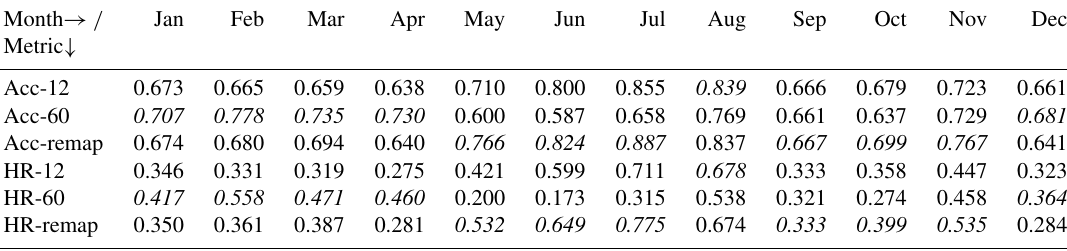
Table 3. Spatial coherence in the identification of extreme AOD values (i.e., areas with AOD>75th percentile over space for each month) between WRF-Chem at different resolutions relative to MODIS. No significant wavelength dependence is found for model skill in identifying extreme AOD so results are only shown for λ = 550nm. The different model output is denoted by 60 for simulations at 60km, 12 for simulations at 12km resolution and as remap for simulations at 12km but with the output remapped to 60km. The accuracy (Acc) indicates the fraction of grid cells co-identified as extremes and non-extremes between WRF-Chem and MODIS relative to the total number of cells with valid data. The Hit Rate (HR) is the probability of correct forecast and is the proportion of cells correctly identified as extremes by both WRF-Chem and MODIS. The italic typeface indicates the model resolution with highest skill in each month for AOD at